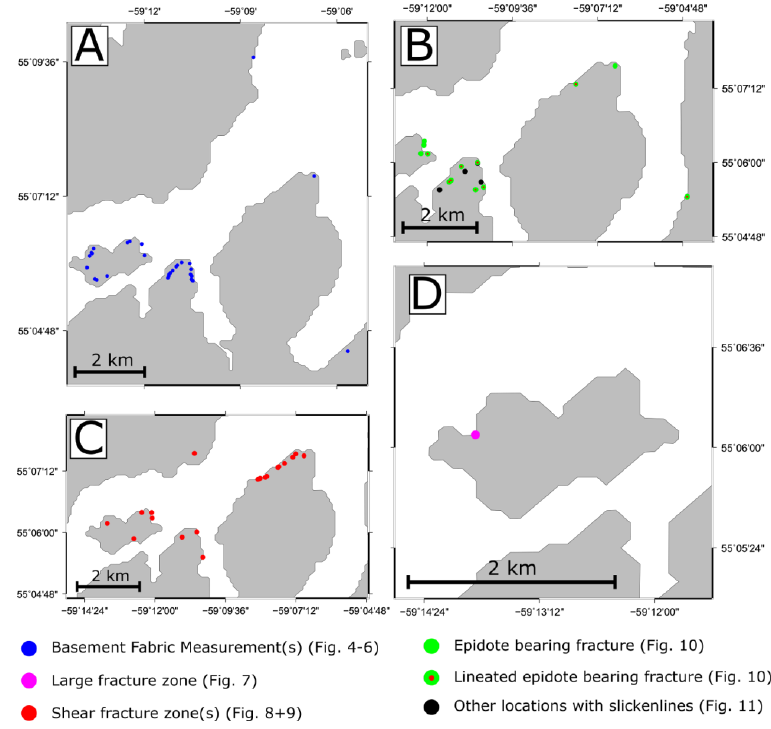
Figure 3. The location of the data analysed, including: ( A ) the locations where basement fabric orientation was measured, ( B ) the locations of the data used in the stress inversion calculations, ( C ) the locations where zones of shear fractures were recorded and ( D ) the large fracture zone on Big